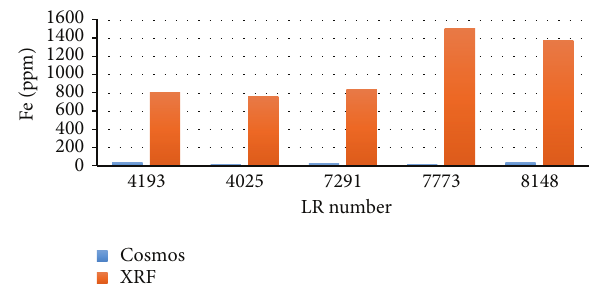
Figure 3: Content of Fe in the gear oil for samples